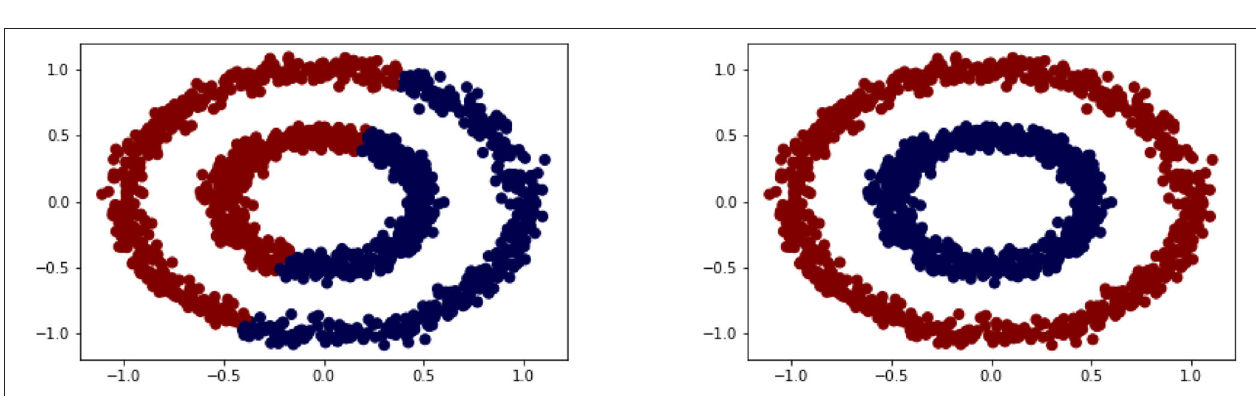
FIGURE 2 | Clustering based on original data via k-means (left) vs. transformed data via spectral clustering (right)